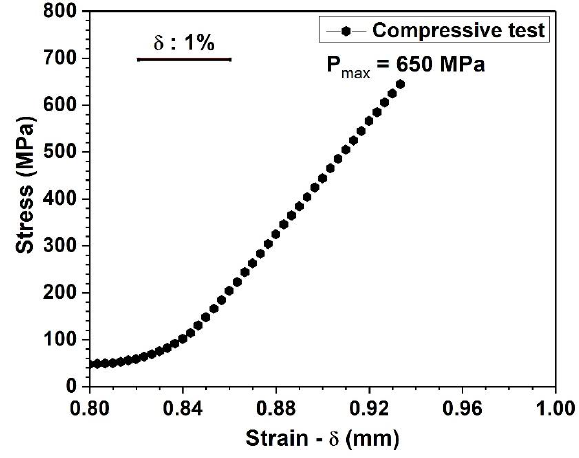
Figure 10. Compression test of sintered samples at 573 K.